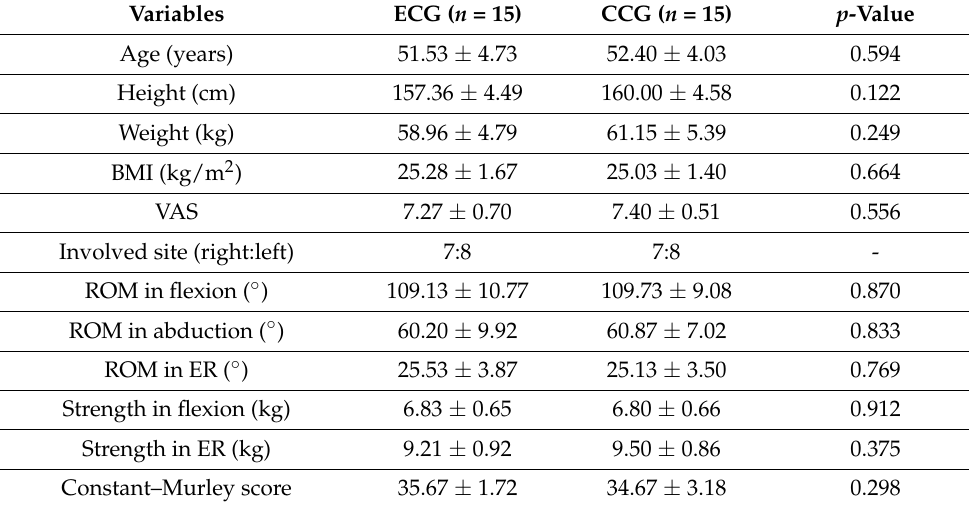
Table 1. Characteristics of the participants in each group.